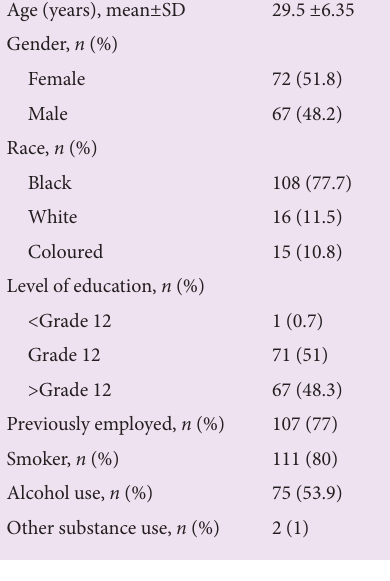
Table 1. Sociodemographic profile of the MPS officers